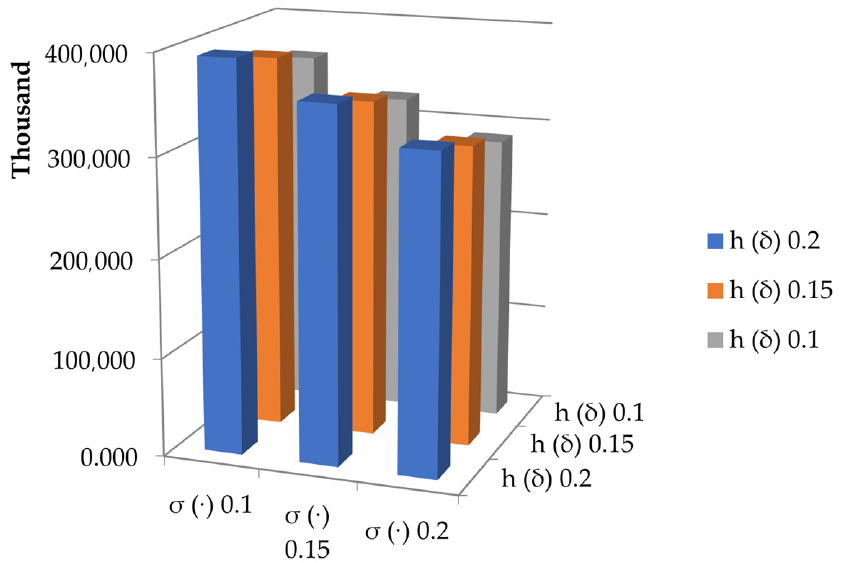
Figure 6. The Principal’s objective function values using B.I.M. with different parameters of stimu- lation and loss functions.